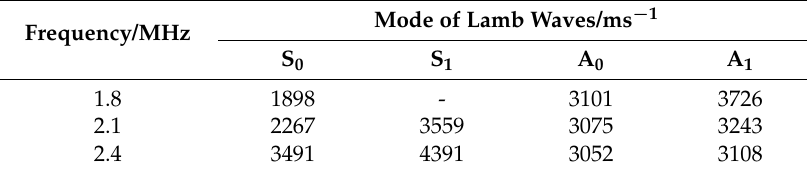
Table 7. Group velocities of different modes of Lamb